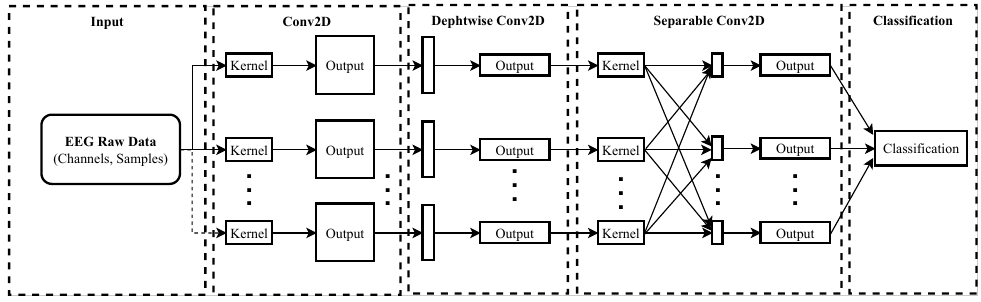
Figure 3. The EEGNet network structure. As a typical CNN, the EEGNet structure additionally disposes of depth-wise and separable convolution layers, allowing features separation for the signal classification